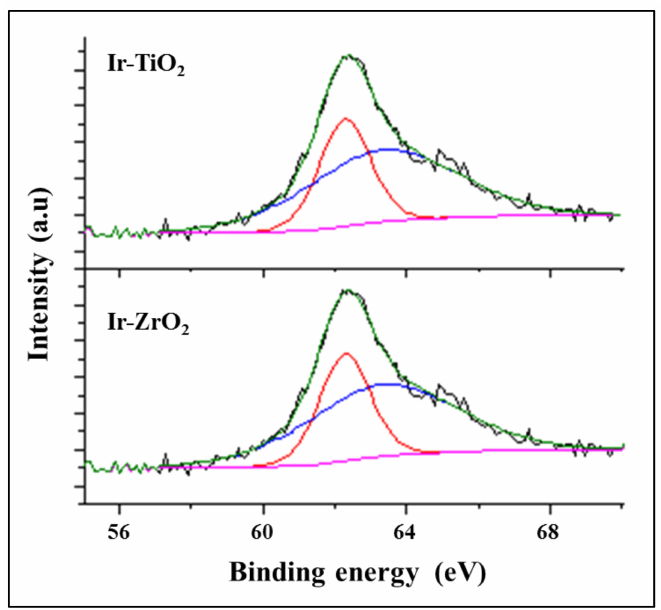
Figure 3. XPS spectra of the Ir4 f 7/2 transition of Ir-TiO 2 and Ir-ZrO 2 .